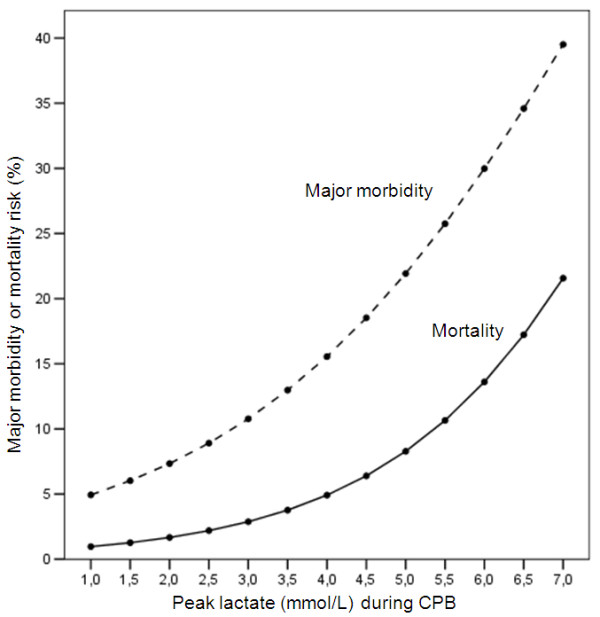
Predicted major morbidity and mortality rates (logistic regression analysis) according to the peak whole blood lactate value, for a cardiopulmonary bypass (CPB) duration of 90 minutes.